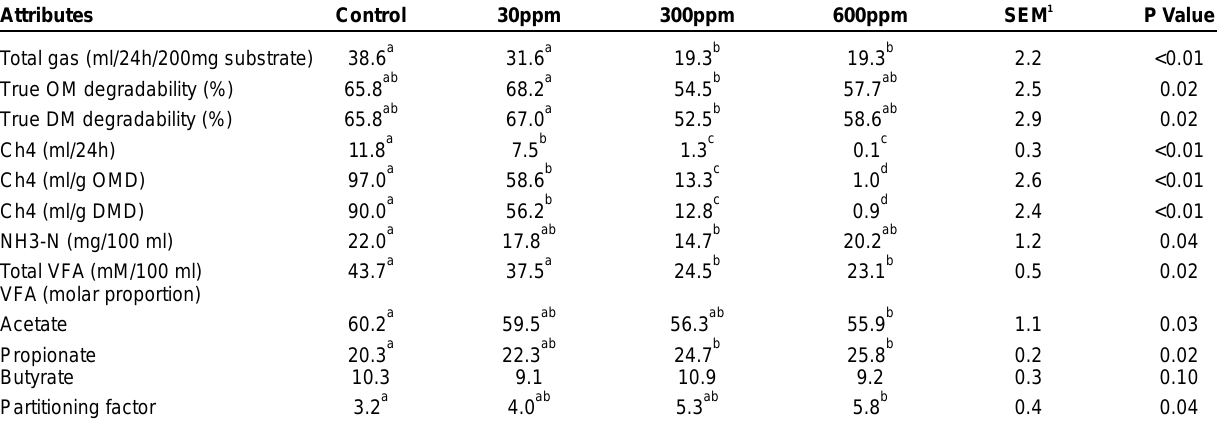
Table-3: Effect of different levels of garlic oil on in vitro fermentation in wheat straw based (Concentrate: Roughage= 50:50)